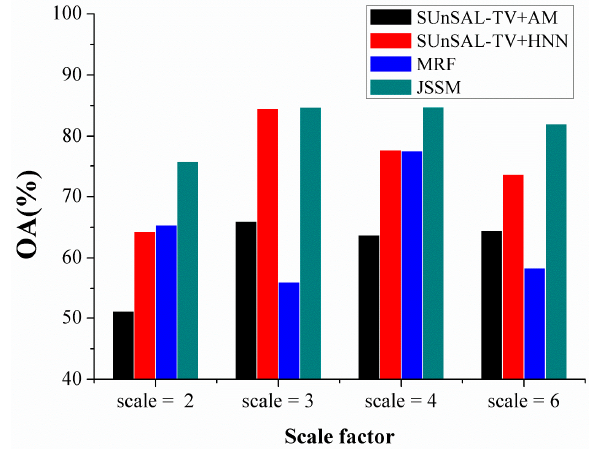
Figure 9. Comparison of the performance of different sub-pixel mapping algorithms given different scale factors for the Indian Pine dataset.